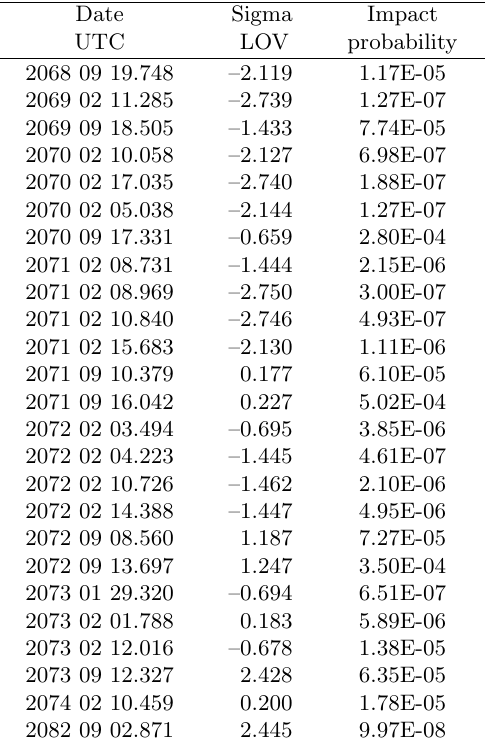
Table 2. Asteroid 2000 SG344. The earliest possible impacts between the years 2068 and 2082. Date Sigma Impact UTC